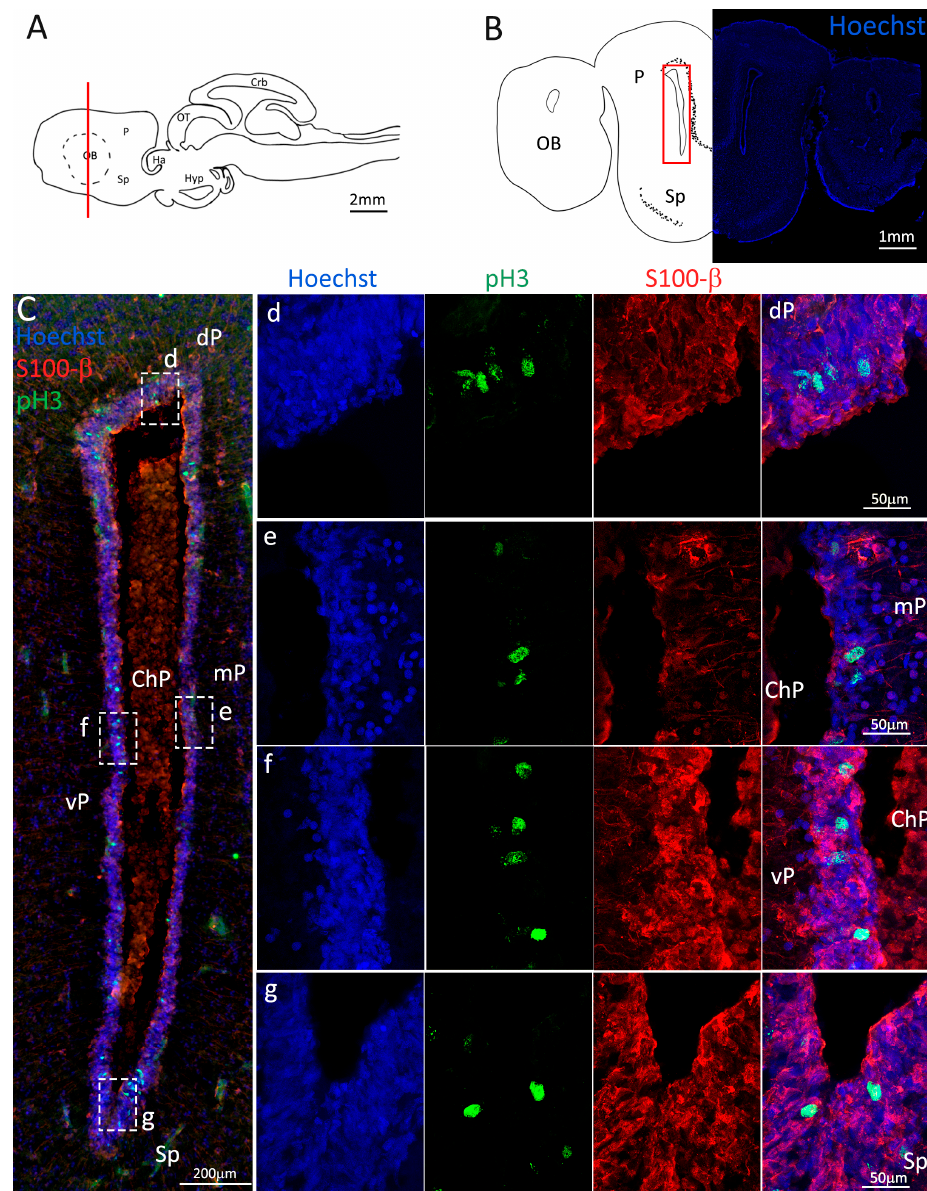
Figure 3. Localization of S100 β (red) and pH3 (green) positive cells in the anterior telencephalon of S. canicula . ( A ) Sagittal representation of S. canicula brain. The red line indicates the rostro-caudal localization of the section represented in the panel. ( B ) Coronal map of the anterior telencephalon. On the right, a real coronal section is stained with Hoechst 33342 to show nuclei distribution; on the left, a cartoon is drawn to indicate anatomical references. Red rectangle identifies the general area from which images are taken. ( C ) Actively dividing cells (pH3 + , green) in the anterior telencephalic neurogenic niche. ( d ) Magnification of the neurogenic niche localized in the dP. ( e ) Magnification of the neurogenic niche localized in the dP. ( f ) Magnification of the neurogenic niche localized in the mP. ( g ) Magnification of the neurogenic niche localized in the vP. Abbreviations: OB: olfactory bulb, P: pallium, Sp: subpallium, dP: dorsal pallium, mP: medial pallium, vP: ventral pallium, ChP: choroid plexus.